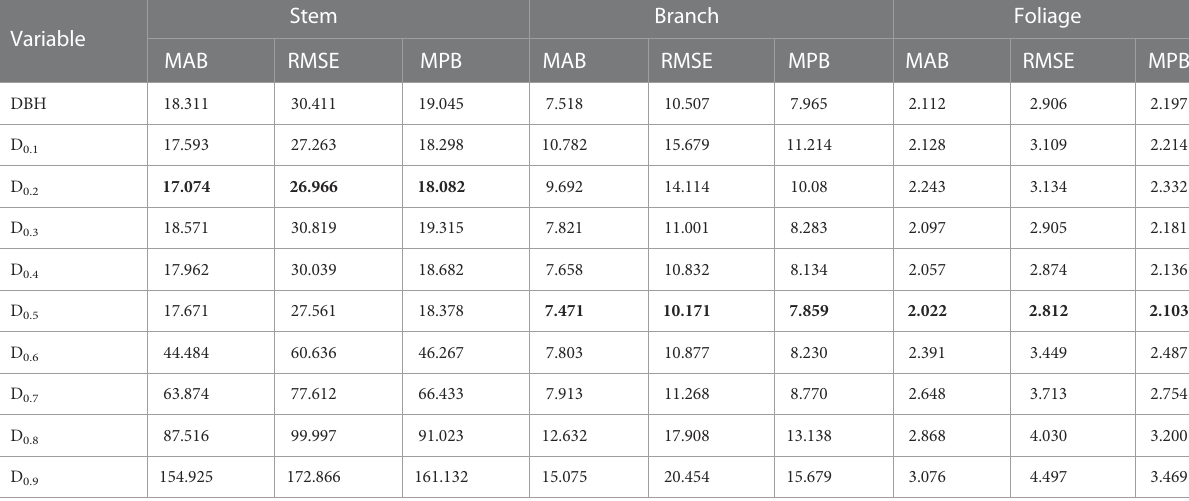
TABLE 5 Goodness-of- fi t statistics of regression biomass models in the cross-validation phase.